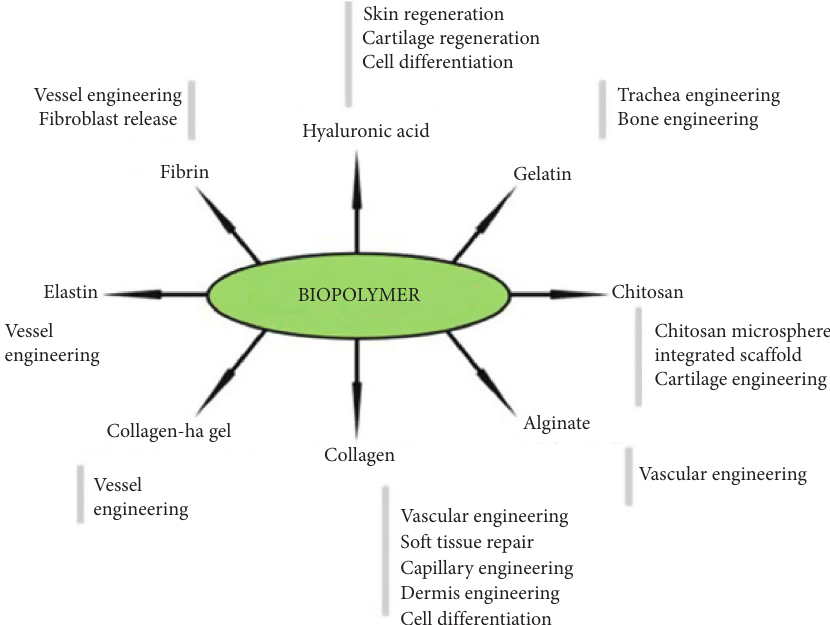
Figure 8: Natural polymers for hydrogel preparation (adapted from [44]).